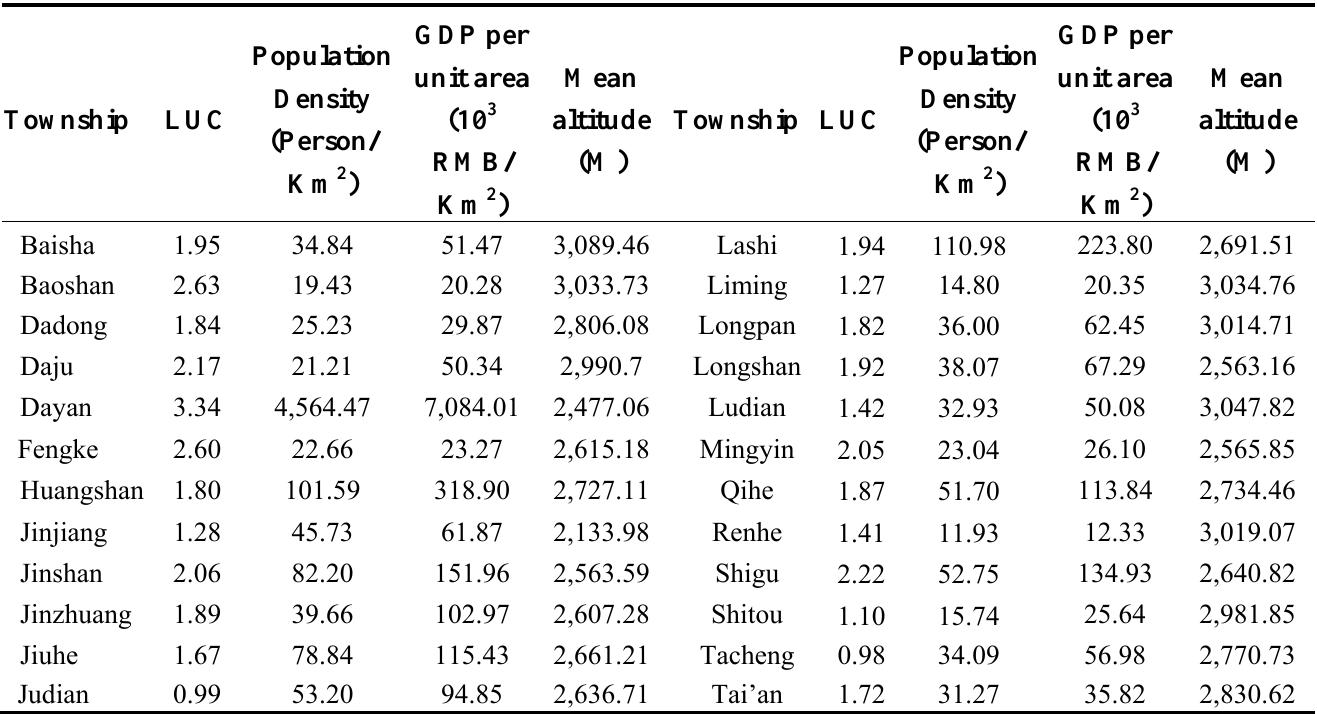
Table 3. Integrated land use change rate and associated influencing factors in different towns of Lijiang County during